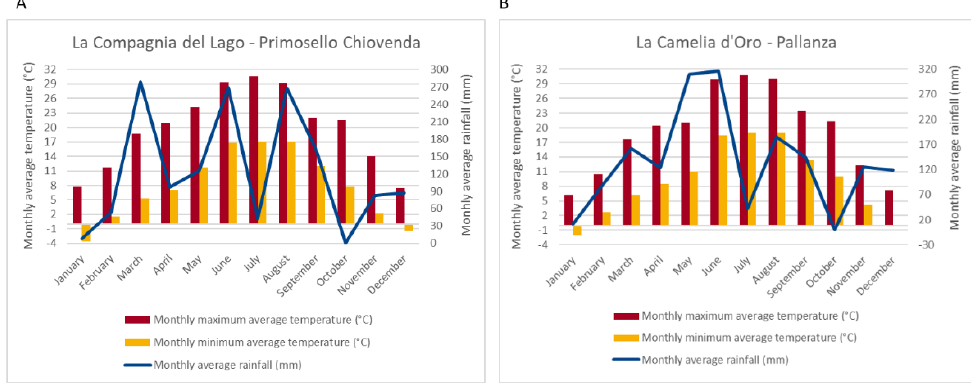
Figure 1. Monthly average temperatures (maximum and minimum— °C), and monthly average rainfall (mm) for the investigation year 2017 in: ( A ). the “Compagnia del Lago” site of cultivation. ( B ). the “Camelia d’Oro” site of cultivation.